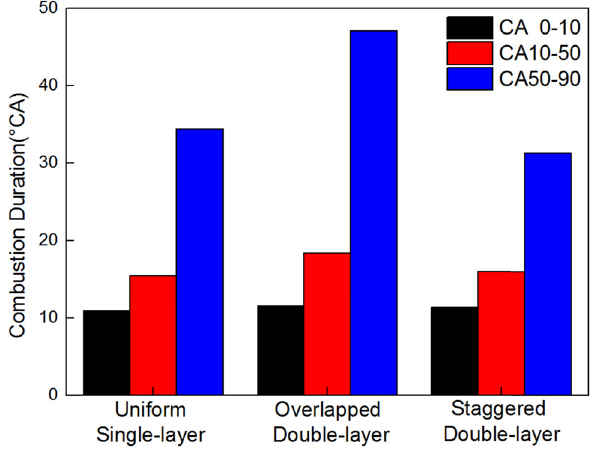
Figure 20: Combustion durations of di ff erent arrangements of